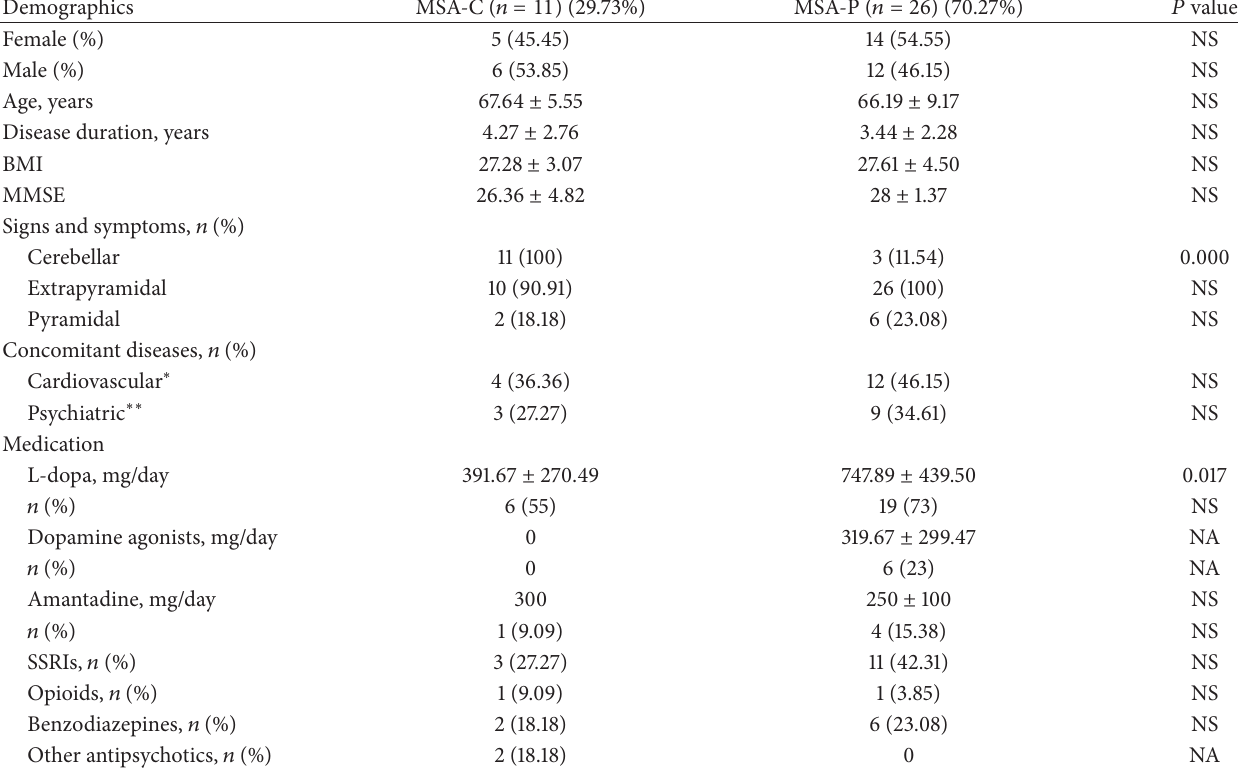
Table 1: Description of the study population with valid